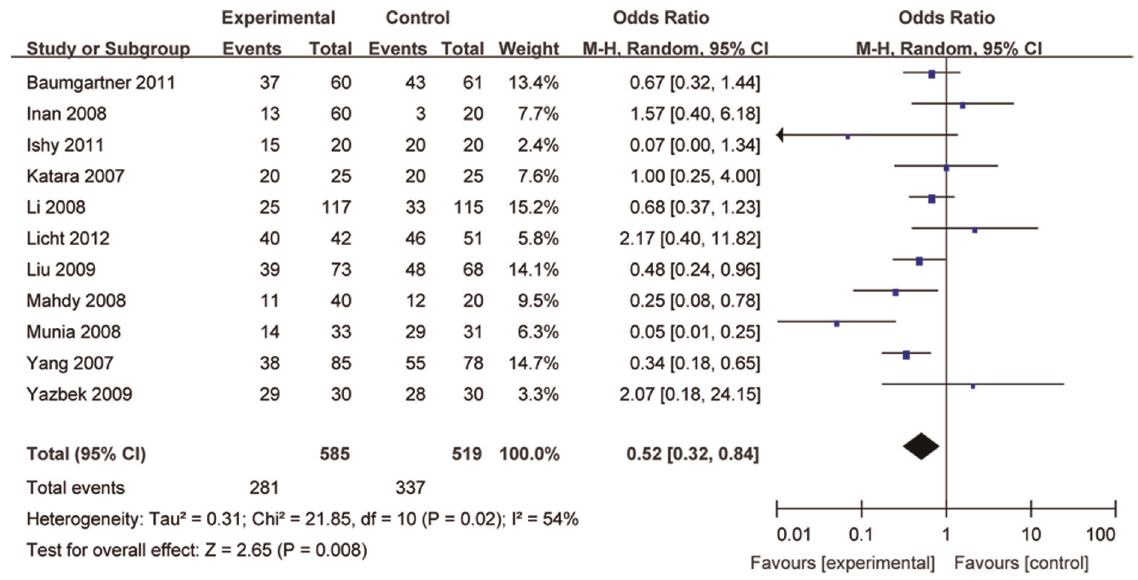
Figure 1 - CS after restricting or lowering the level of sympathectomy. CI, confidence interval; CS, compensatory